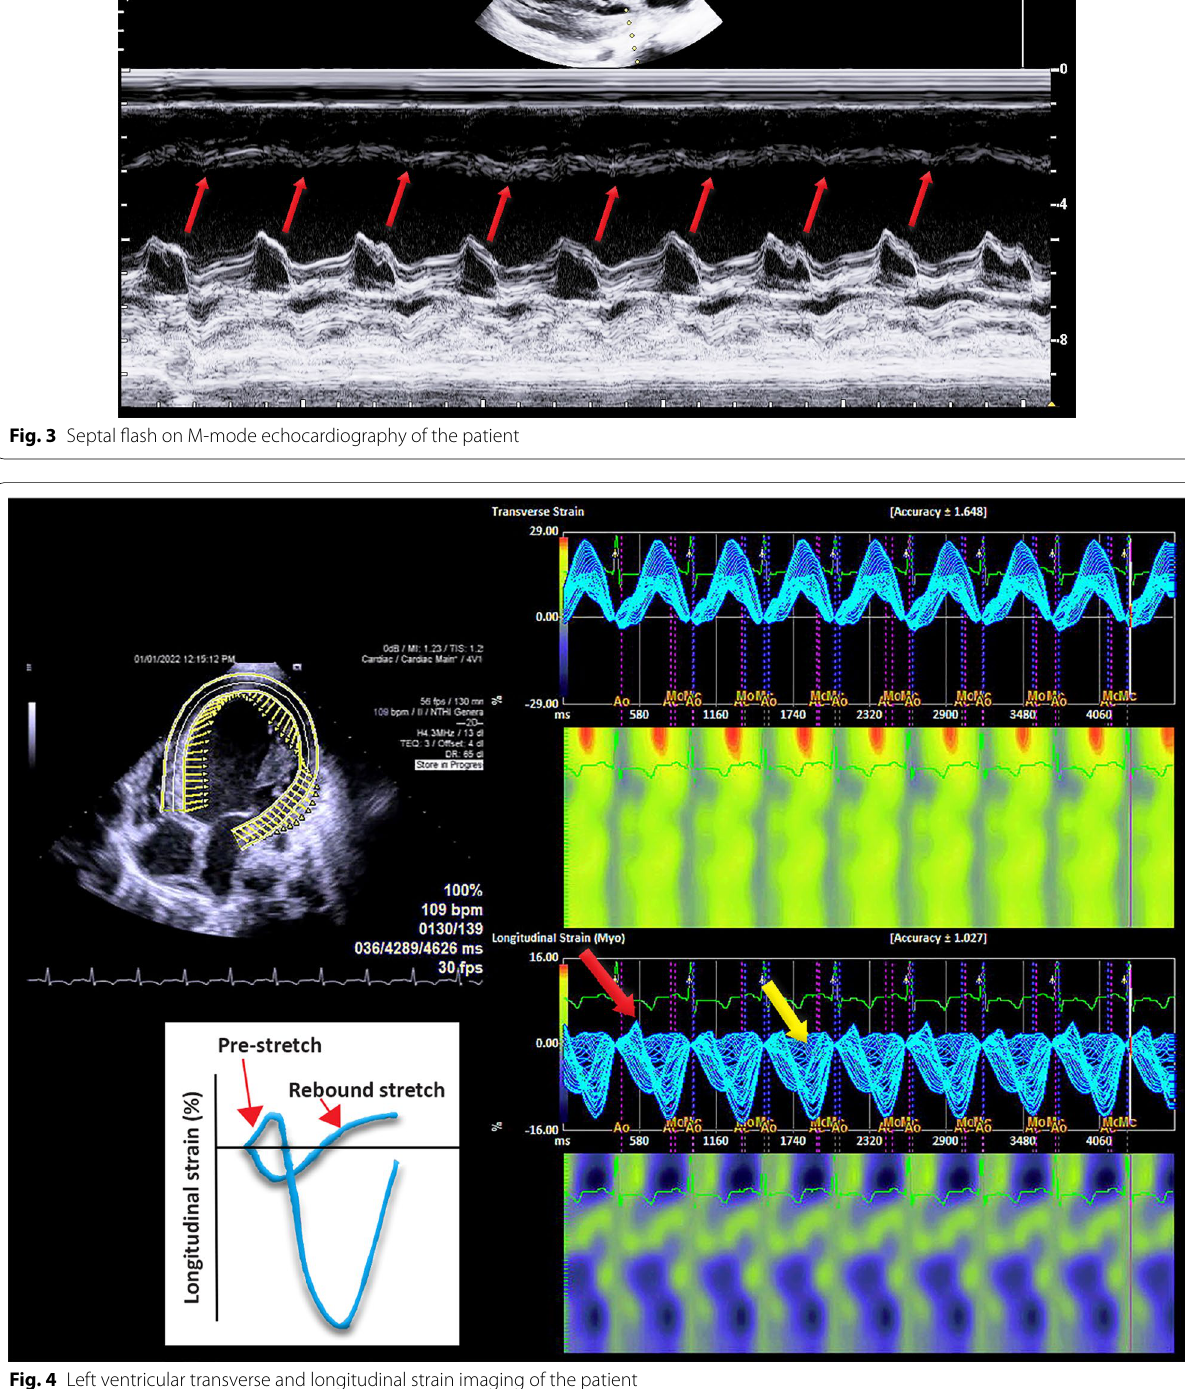
Fig. 4 Left ventricular transverse and longitudinal strain imaging of the